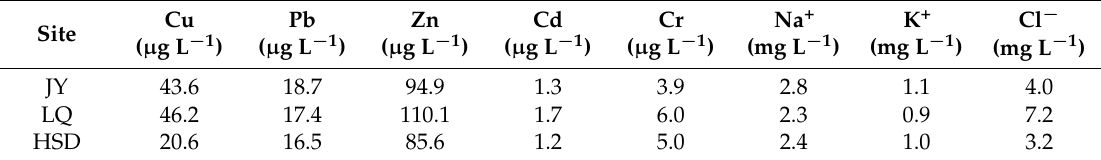
Table 5. The background contents of Cu, Pb, Zn, Cr, Cd, Na + , K + , Cl − in groundwater in different turfy swamp